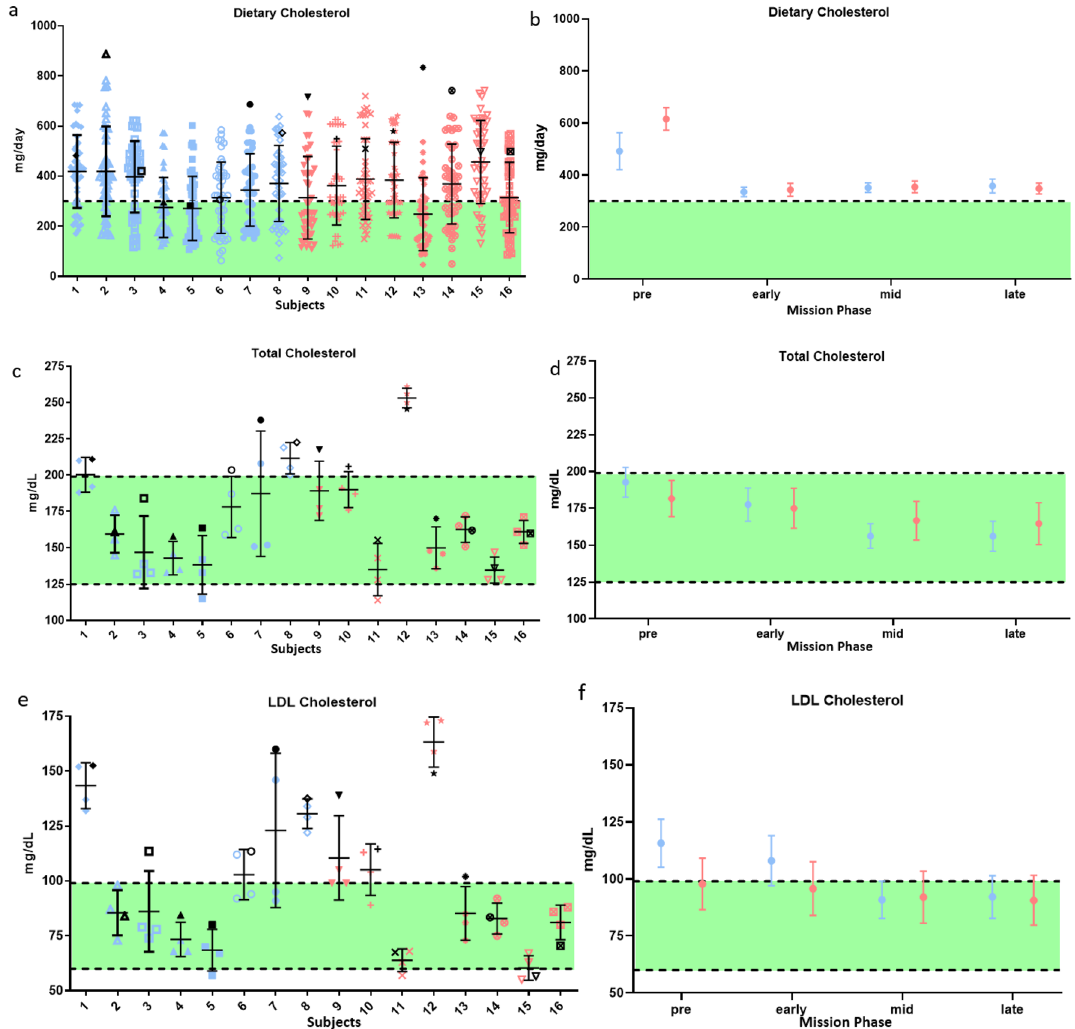
Figure 2. Cholesterol intake and serum status in-mission compared to pre-mission average. In a, c, and e each vertical set of samples represents one individual on the enhanced diet (blue) or the standard diet (red). Black symbols denote individual pre-mission average. In b, d, and f plots represent the mean ± SE of all subjects on the enhanced diet (blue) or the standard diet (red) during different phases of the mission. ( a,b ) Cholesterol intake was similar between diets. ( c,d ) Total cholesterol and ( e,f ) LDL cholesterol decreased more for subjects on the enhanced diet compared to the standard diet. Green area represents target intake levels that met requirements. More information is available in SI Appendix , Tables